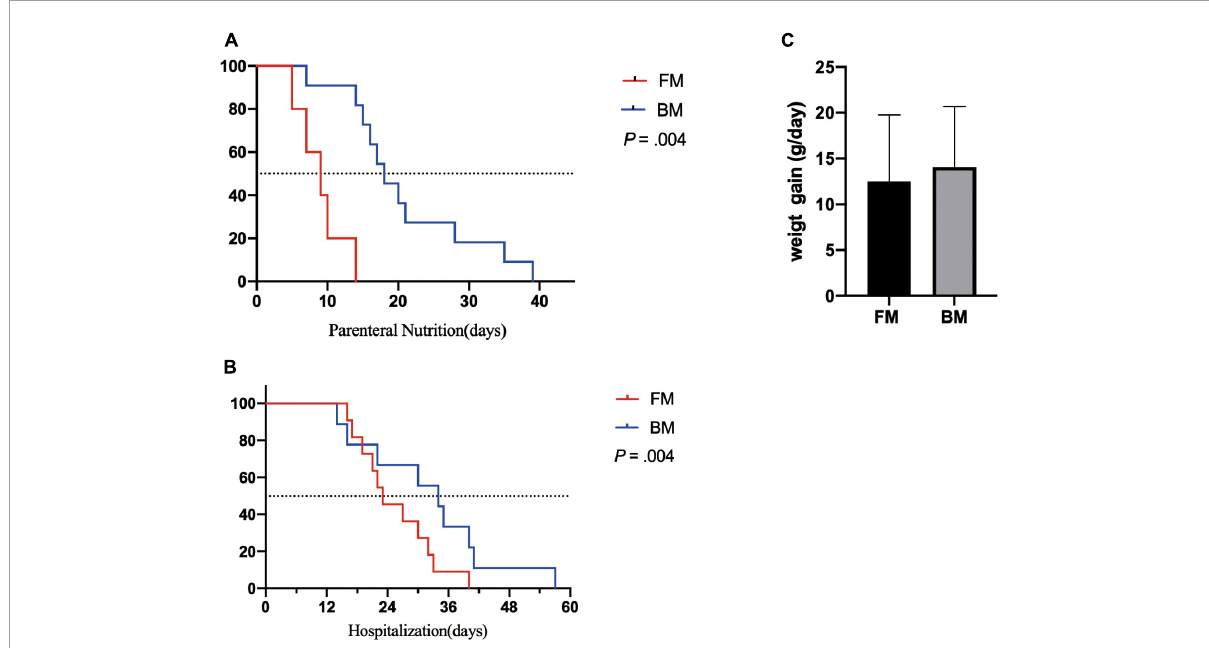
FIGURE1 Major clinical outcomes between premature infants fed by breast milk and formula milk. (A) The days for parenteral nutrition between two groups. (B) The body weight gain per day (g/day) among infants. (C) The duration of hospitalization between two groups. p < 0.05 was considered a significant